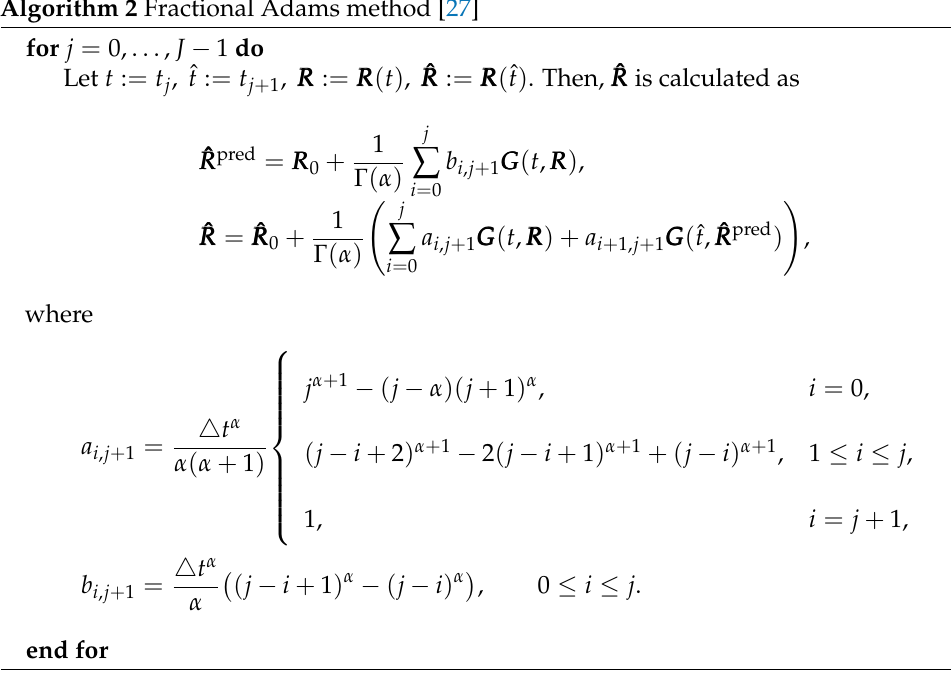
Algorithm 2 Fractional Adams method [27]